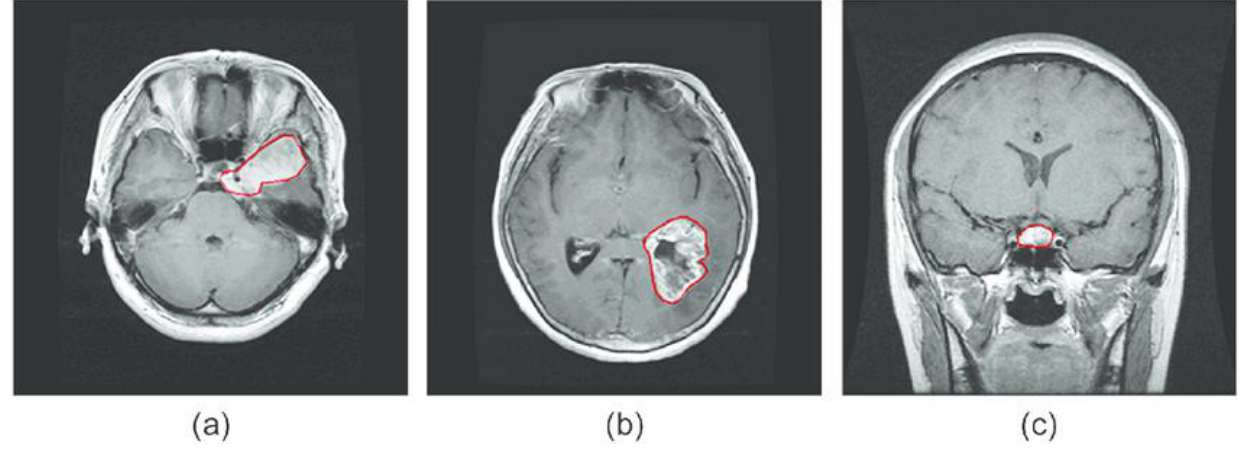
Figure 2. MRI images of three categories ( a – c ) (glioma, pituitary, and meningioma). Table 1. A description of the brain data set.